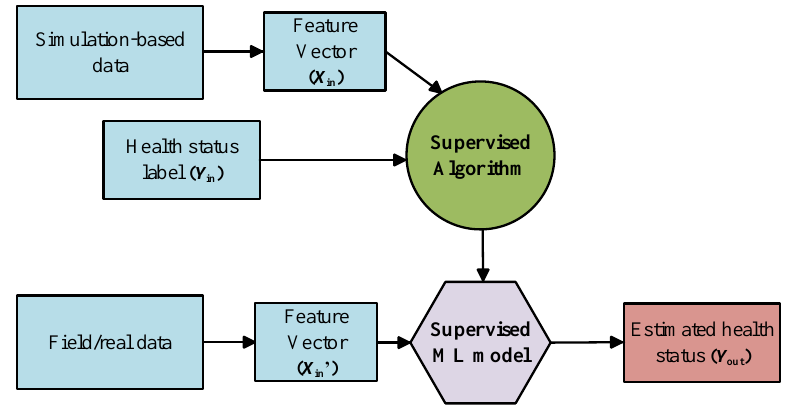
Figure 10. Schematic of the supervised ML